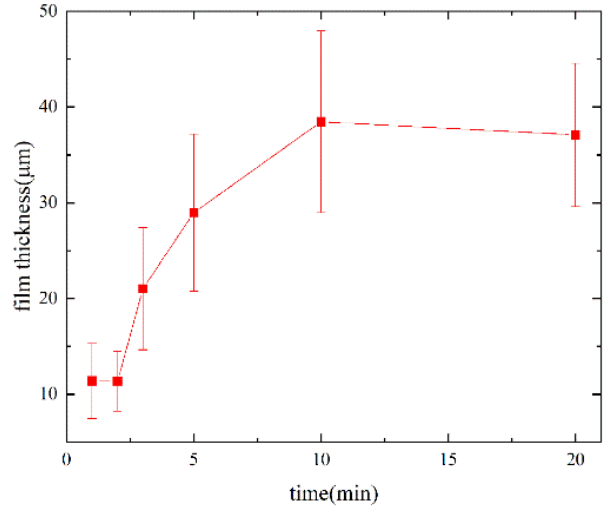
Figure 5. Film thickness versus immersion time.